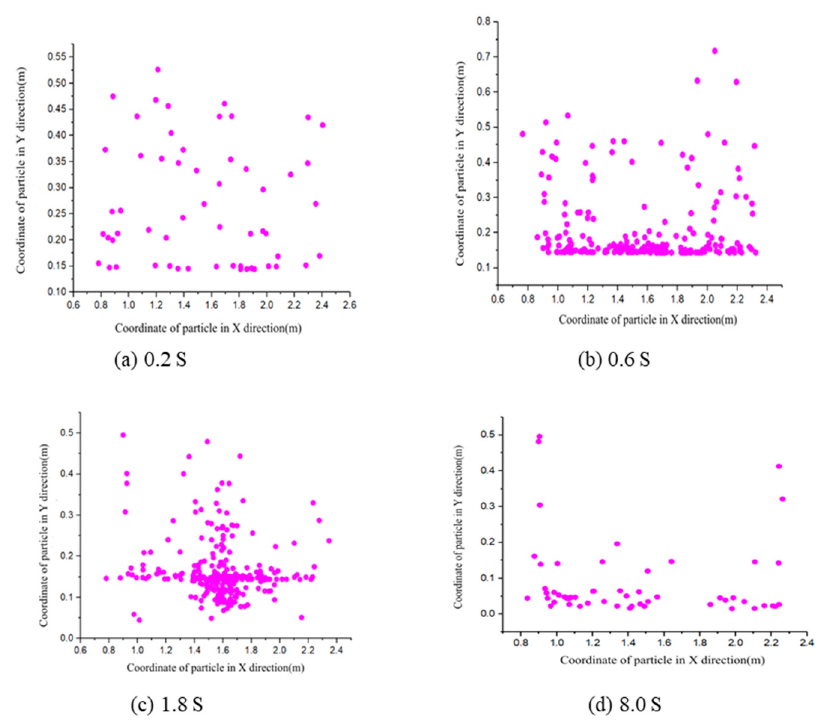
Figure 16. The motion of the stems in the device. (a) 0.2 S ; (b) 0.6 S ; (c) 1.8 S ; (d) 8.0 S . The movement process of the stems in the Z -axis direction is shown in Figure